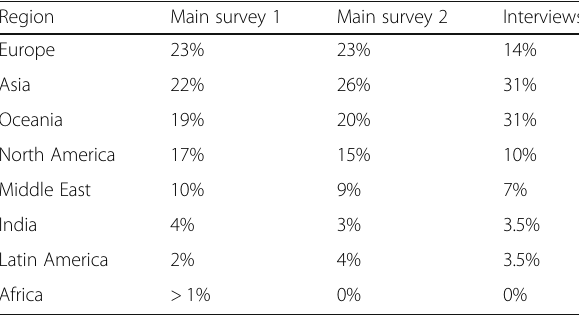
Table 3 Regions of best industry knowledge